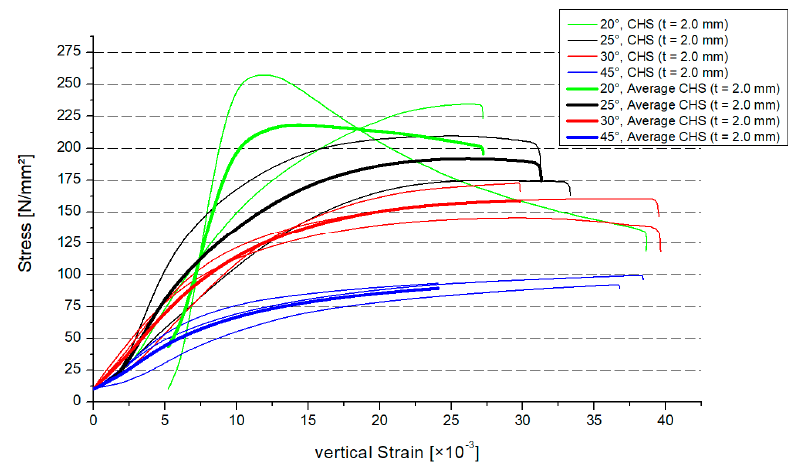
Figure 6. Stress–strain distribution, CHS t = 2.0 mm.